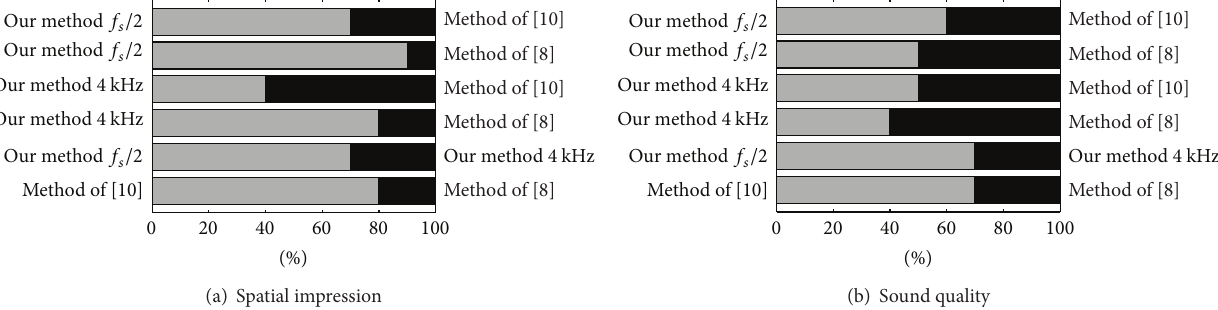
Figure 15: Preference listening test results for the rock music recording with binaural